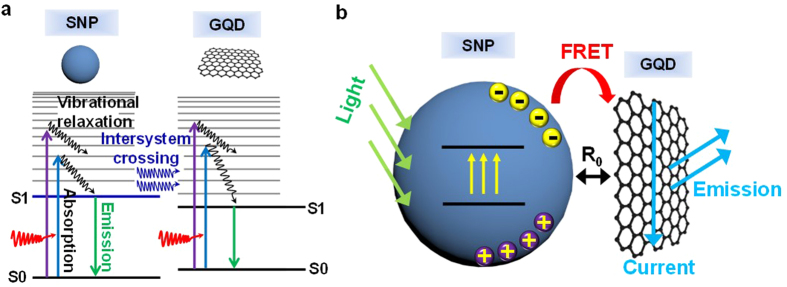
Schematic diagrams describing the FRET system.(a) Band structures of SNP and GQD. Possible absorption/emission/transfer processes are described. Here, S0 and S1 indicate ground and lowest excited states, respectively. SNPs are highly absorptive, especially in the range of the emission spectrum of GQDs. Differently-colored PL of variously-sized GQDs ranges from UV to near-infrared region. (b) A schematic of a typical FRET system composed of SNPs and GQDs as donors and acceptors, respectively. Photo-excited electron-hole pairs occupy mostly the surface states of SNPs, thereby making it easy to transfer energy to adjacent GQDs. The distance at which the FRET efficiency drops to 50% is defined as the Förster radius (R0), typically in the range of 1–10 nm. The use of one-atom-thick GQDs for acceptors can minimize R0 and maximize the contacting area of the acceptors and the donors.